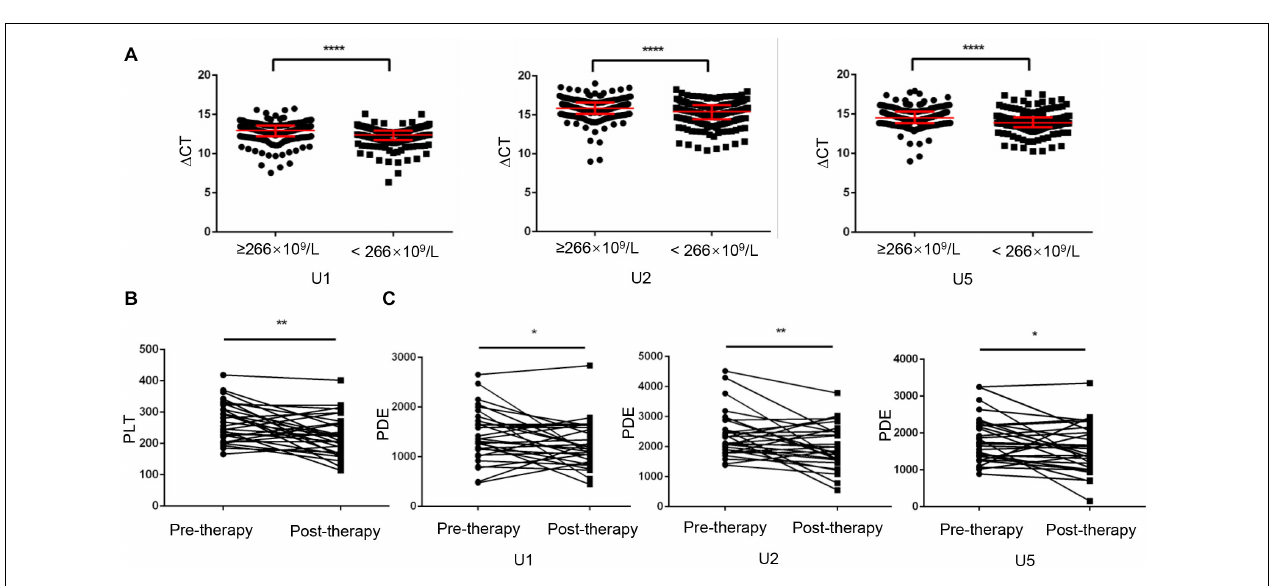
FIGURE 5 | Platelet-count dependent expression of U1, U2 and U5 was elevated by anticancer therapy. (A) TEP U1, U2, U5 expression was down-regulated in high platelet counts patients ( n = 192) compared with that in low platelet counts patients ( n = 189); (B) The platelet count levels were significantly lower in the post-therapy patients than in paired pre-therapy patients ( n = 30); (C) The PDE levels were significantly lower in the post-therapy patients than in paired pre-therapy patients; * P < 0.05; ** P < 0.005; **** P <